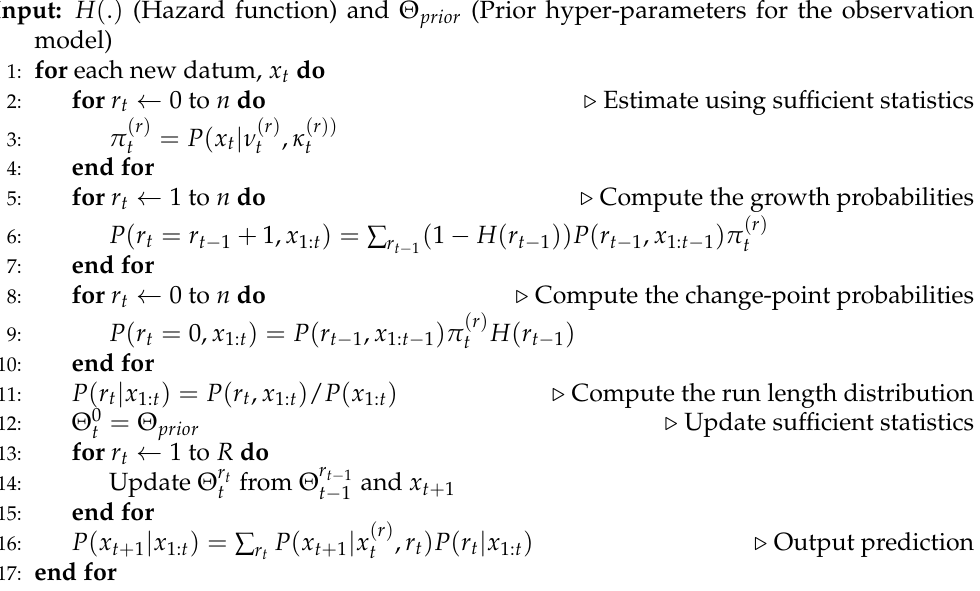
Algorithm 1 BOCPD